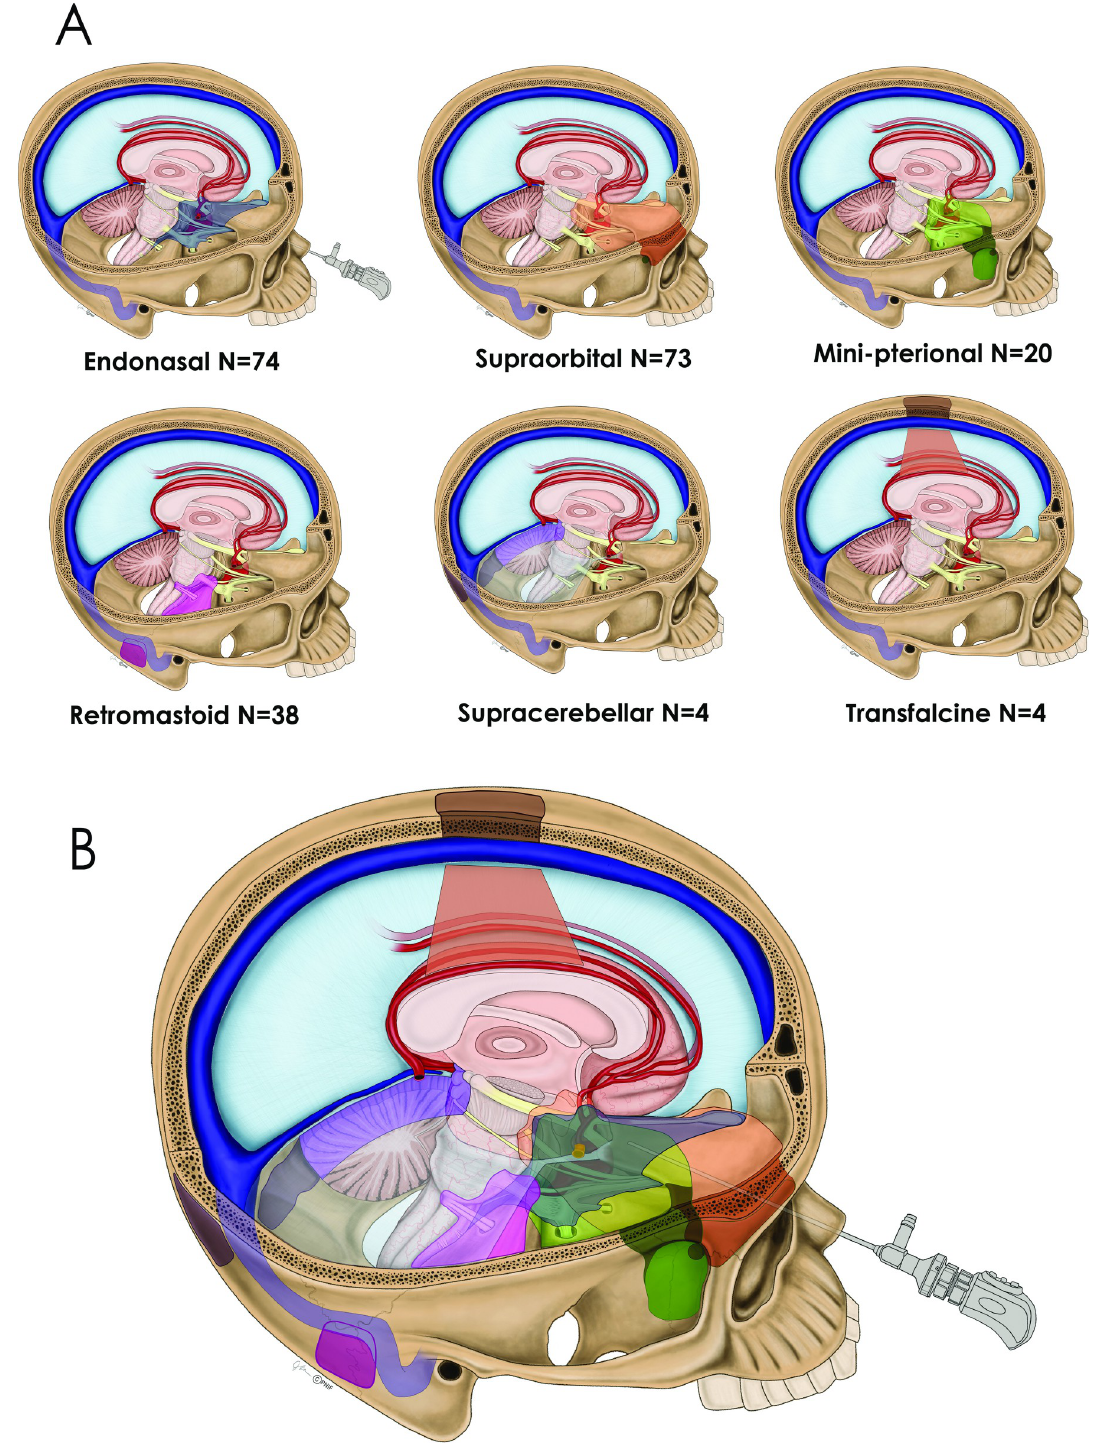
Fig 1. (1A) Drawing depicting 6 keyhole approaches for meningioma removal: endonasal, supraorbital, minipterional, retromastoid, suboccipital sitting gravity-assisted and transfalcine gravity-assisted, along with the total number of surgeries for each approach. (1B) A composite of the 6 keyhole